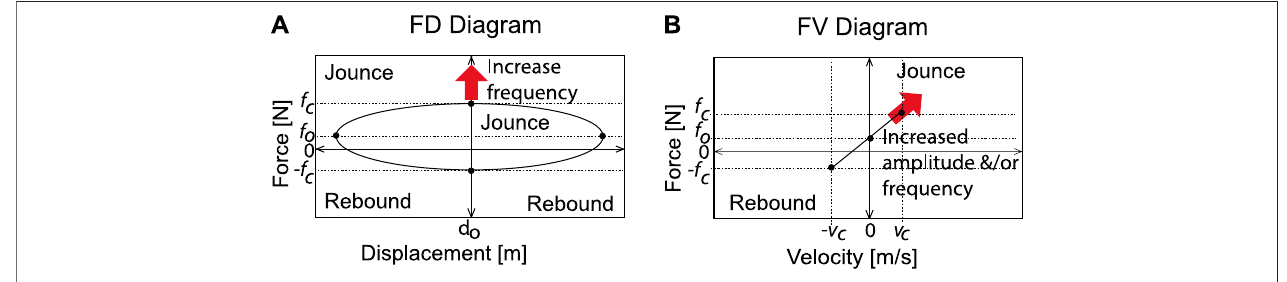
FIGURE 3 | Characteristic diagrams at ω B , Type-0 .